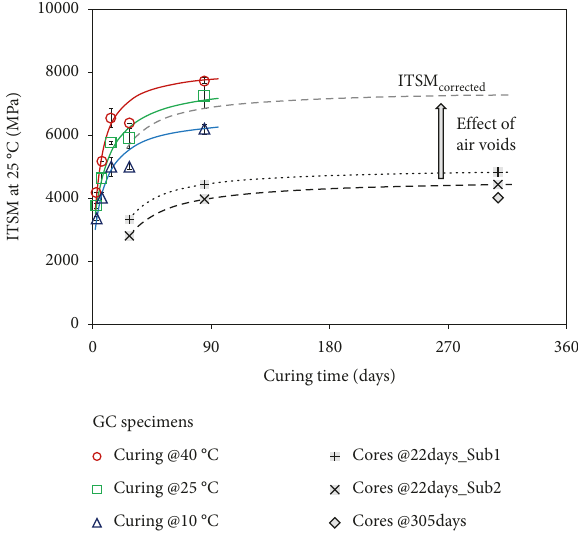
Figure 13: Voids of the GC specimens and field cores. Moisture and temperature variation within the CRM